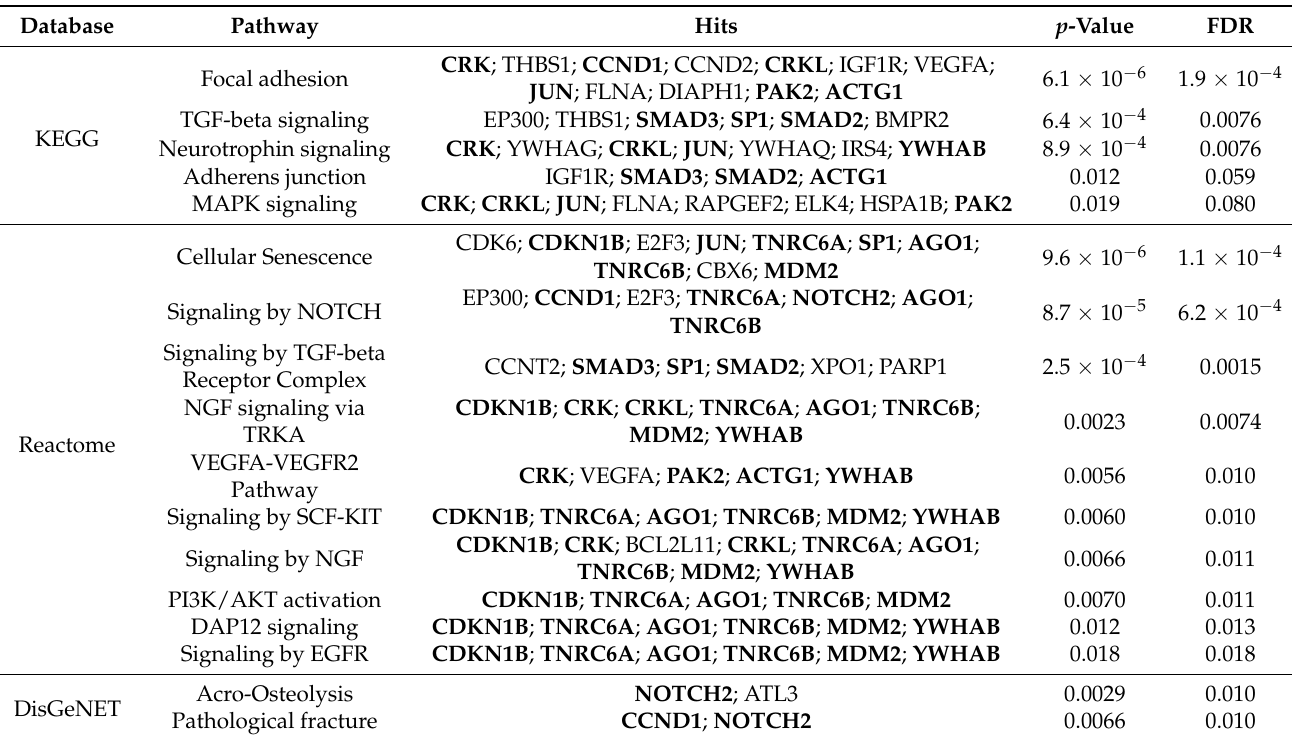
Table 3. Pathway enrichment using the KEGG, Reactome, and DisGeNET databases. Several pathways significantly enriched with an adjusted p value < 0.2 (FDR < 20%) were identified for the thirty-seven dysregulated bone miRNAs. The top targeted genes most commonly present in the identified pathways are highlighted in bold (16